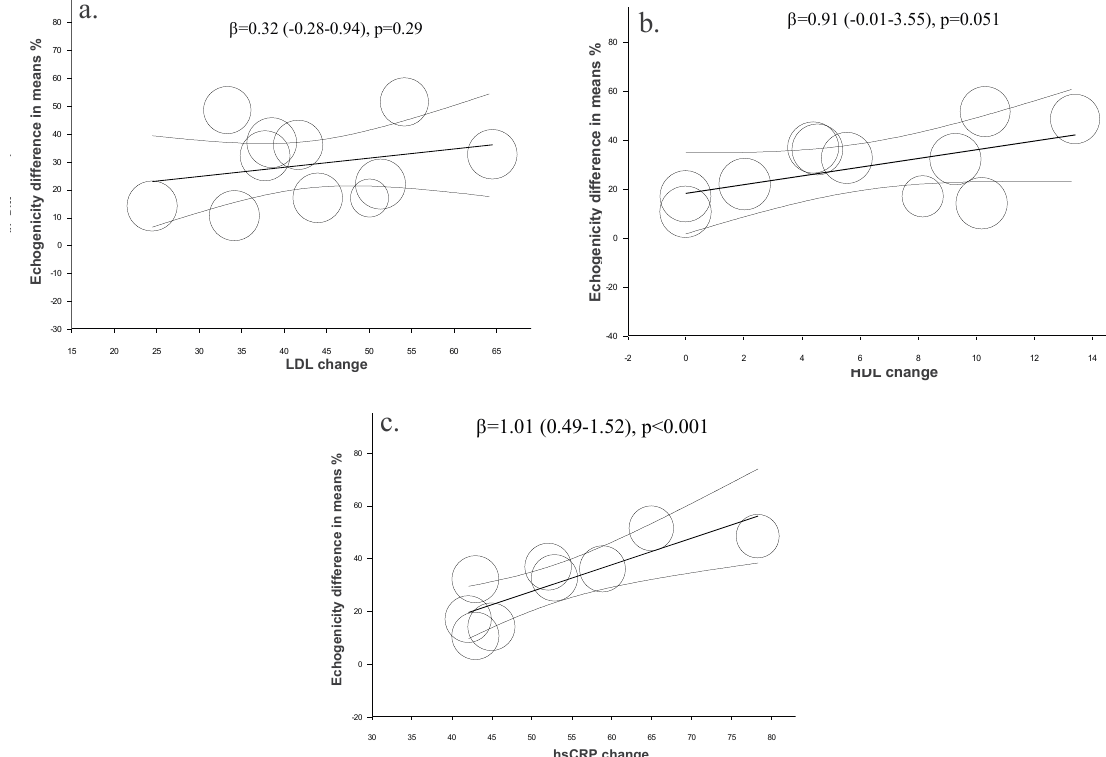
Figure 3. Meta-regression. Regression of LDL ( a ), HDL ( b ) and hsCRP ( c ) changes on plaque echogenicity after statin